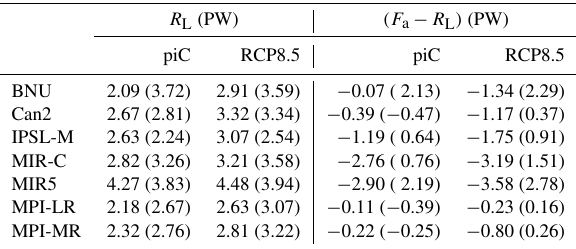
Figure 9. Latent heat transport between the Equator and 10 ◦ N for the seven models in the three scenarios. The transport increases from piC to RCP8.5. Values are in watts and are positive if north- ward directed. Table 6. Evolution of land–ocean asymmetries for latent energy and for the residual of the atmospheric budget for 20 years of multi- model ensemble simulations under the two extremal scenarios (piC and RCP8.5). Values are in petawatts (PW) and are positive if they are directed toward land. Values in brackets are from spatial inte- gration over land; those not in brackets are from integration over